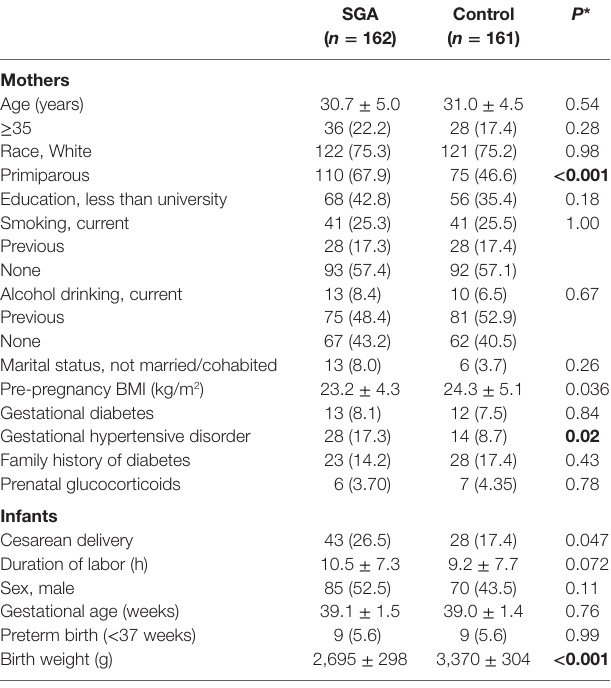
TaBle 1 | Maternal and infant characteristics of study subjects.